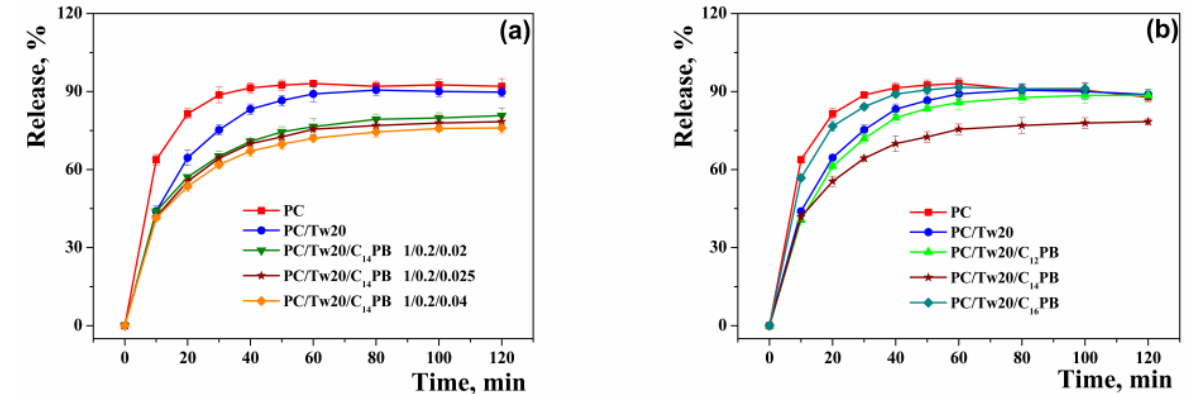
Figure 3. In vitro 2-PAM release from transfersomes, modified with: ( a ) C 14 PB at different molar ratio of components; ( b ) C n PB at constant molar ratio of components 1/0.2/0.025, phosphate buffer (0.025 M), pH = 7.4, 37 °C.